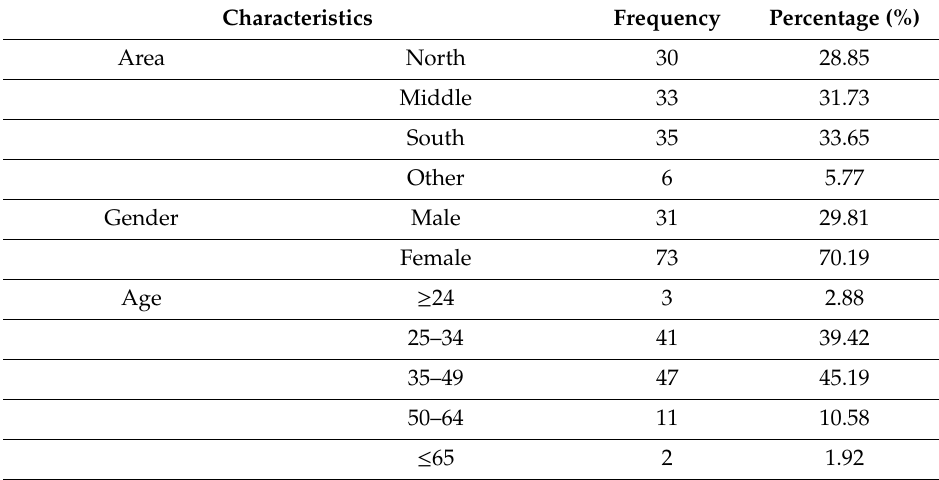
Table 1. Demographic